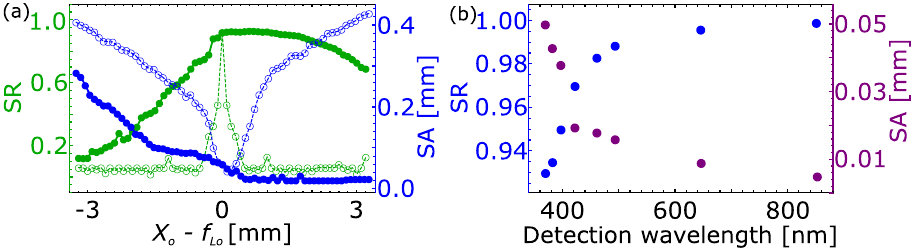
Figure 5. ( a ) Change in SR (green empty circle) and SA (blue empty circle) values of the images due to inaccurate positioning of the collection lens L with respect to its focus f L . Corresponding SR (green full circle) ◦ ◦ and SA (blue full circle) after incorporating corrections by tuning the magnifier’s position are also shown. ( b ) SR and SA at different wavelengths (corresponding to different species), e.g., 369.5 nm (Yb + ), 382 nm (Ra + ), 397 nm (Ca